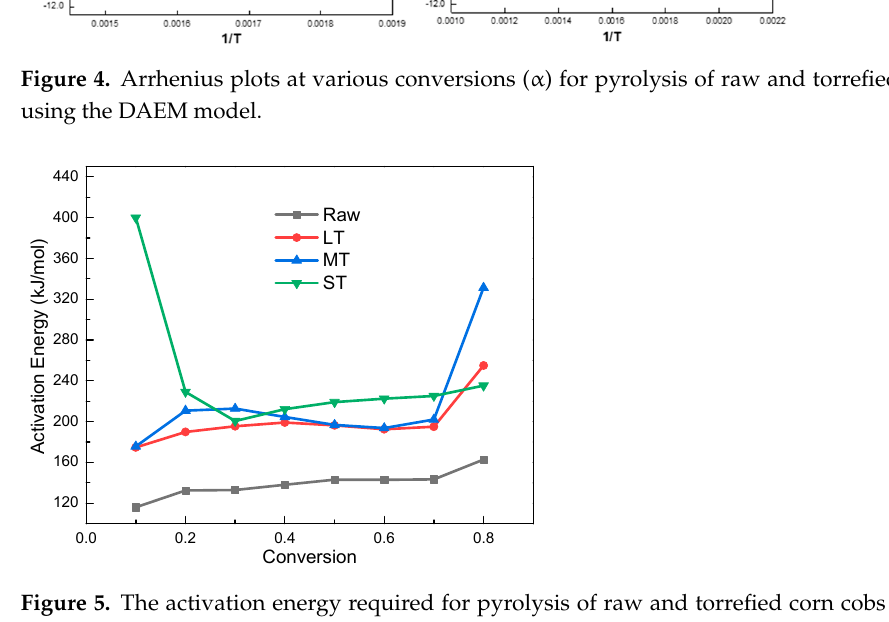
Figure 5. The activation energy required for pyrolysis of raw and torrefied corn cobs at carrying conversion rates using DAEM.